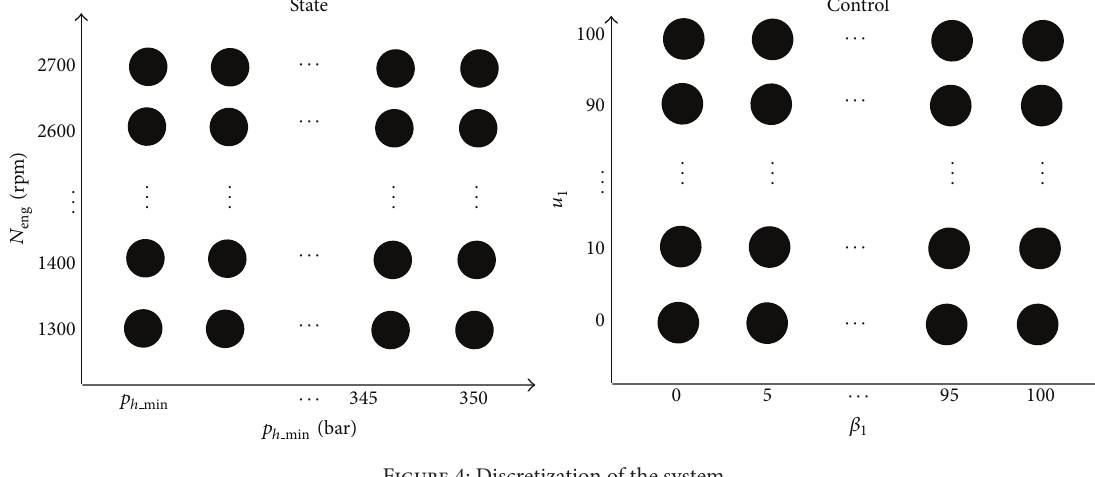
Figure 4: Discretization of the